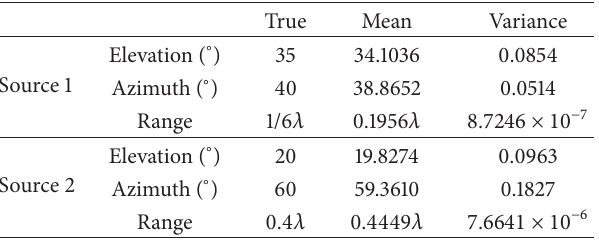
Table 1: The mean and variance of the proposed method for the second